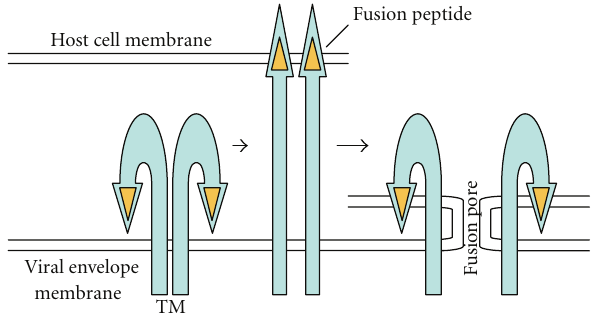
Figure 1: Conformational change of retroviral TM subunit for membrane